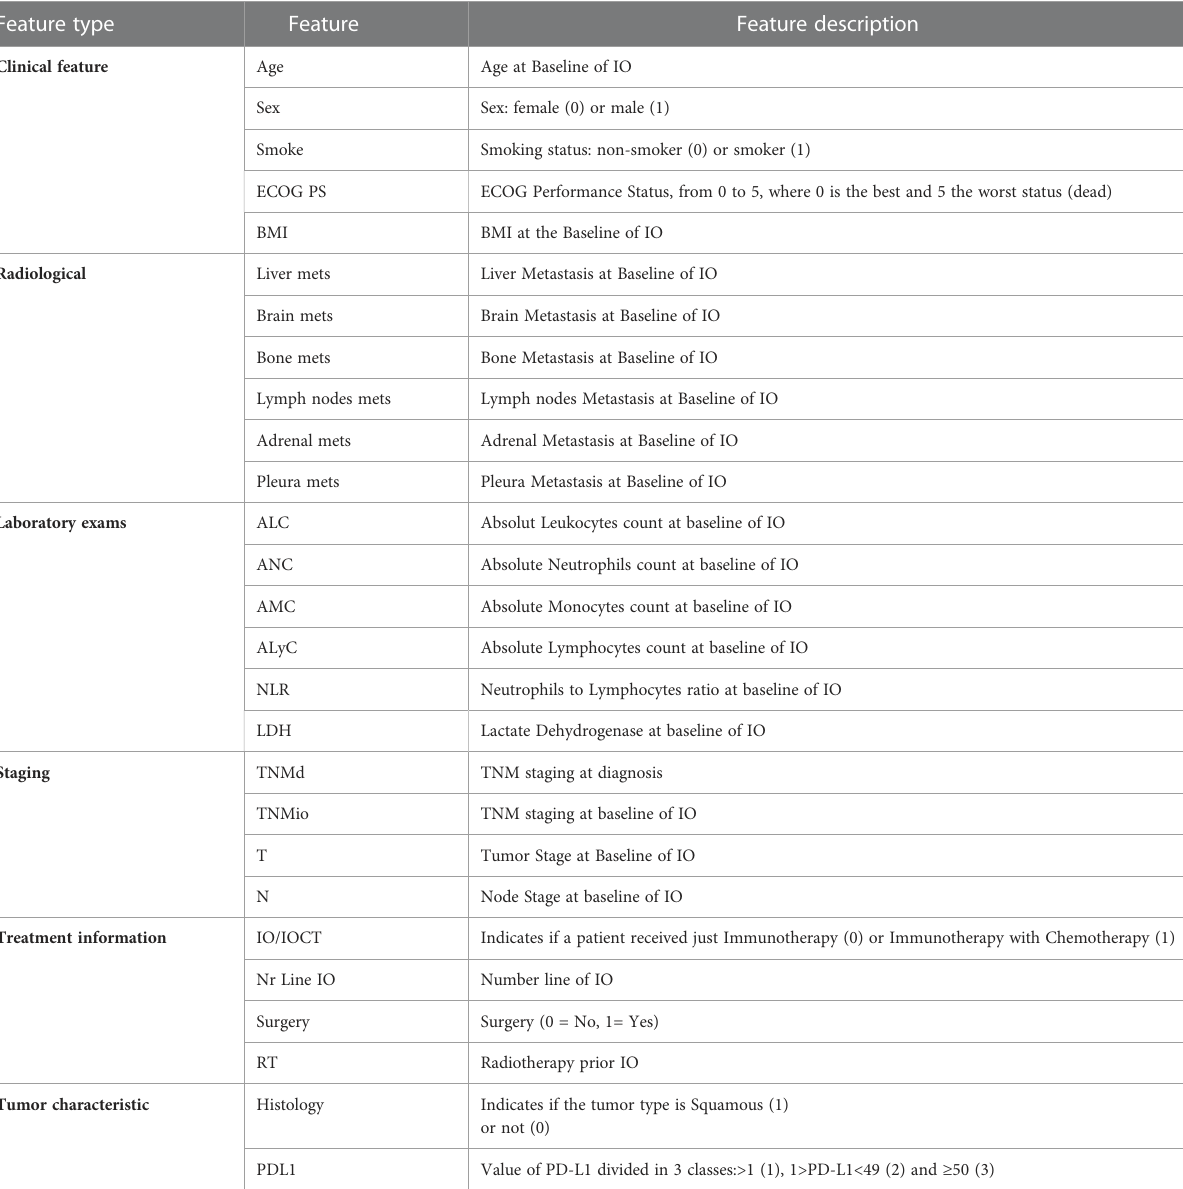
TABLE 1 Selected